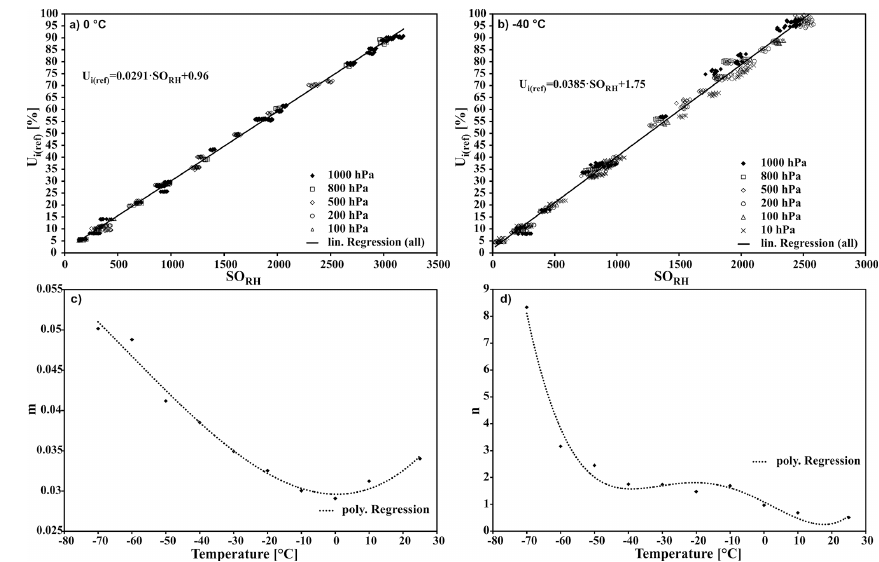
Figure 9. All SO RH values of the nine SHT75 at (a) 0 ◦ C and (b) − 40 ◦ C; (c) slope m and (d) offset n of the linear regression fit for all temperatures.